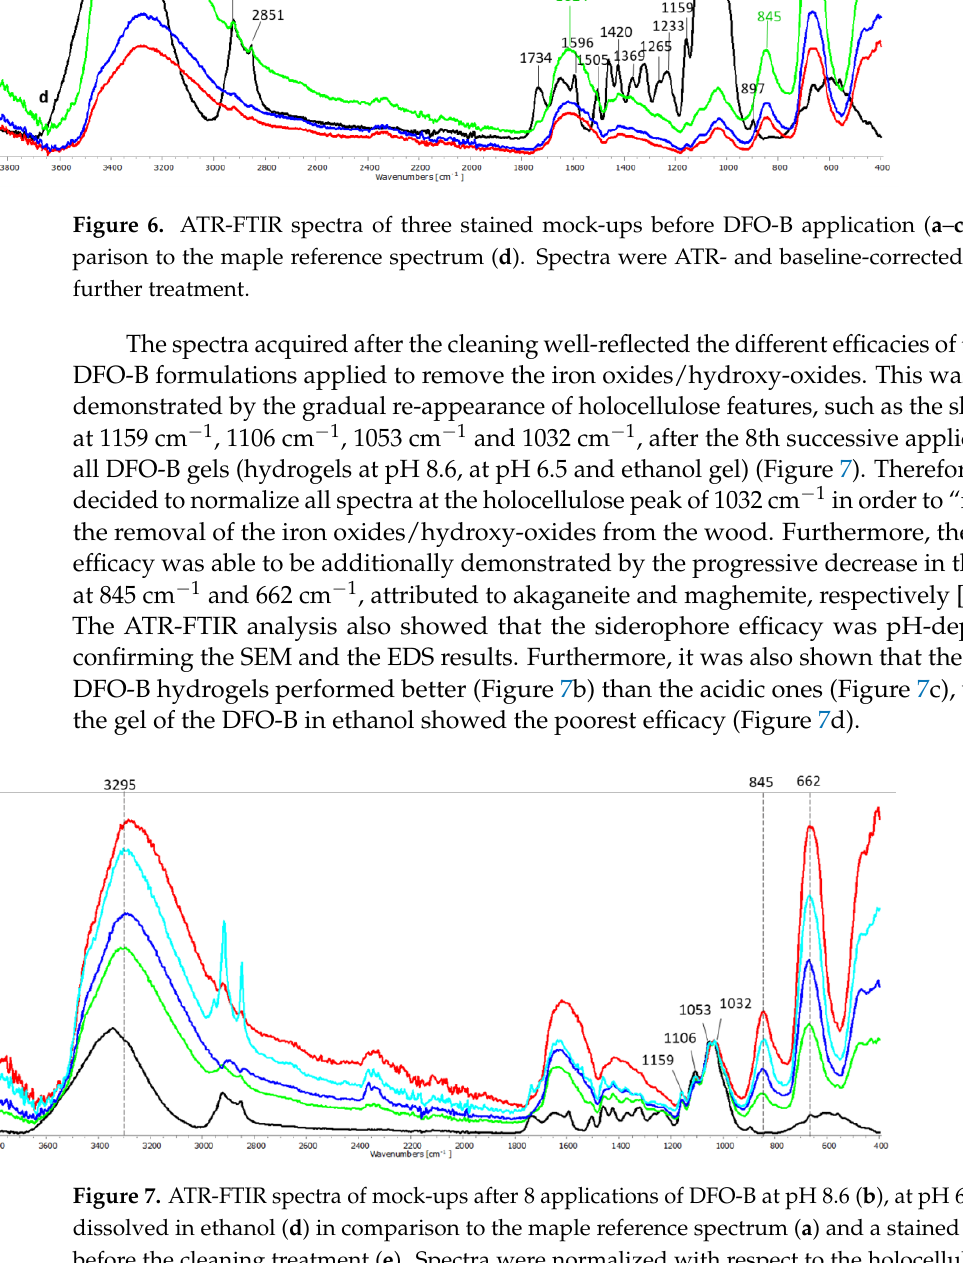
9 of 15 Figure 5. Cleaning efficacy (%ΔFe) calculated from iron weight (%wt) detected via EDS on mock- ups after 8 applications of DFO-B at pH 6.5, at pH 8.6 and dissolved in ethanol. All values are aver- ages of four replicates. 3.1.3. Attenuated Total Reflection – Fourier Transform Infrared Spectroscopy (ATR-FTIR) The ATR-FTIR spectra of the maple reference sample (Figure 6d) clearly show the wood fingerprint peaks, including lignin at 1596 cm − 1 , 1505 cm − 1 , 1420 cm − 1 and 1265 cm − 1 ;